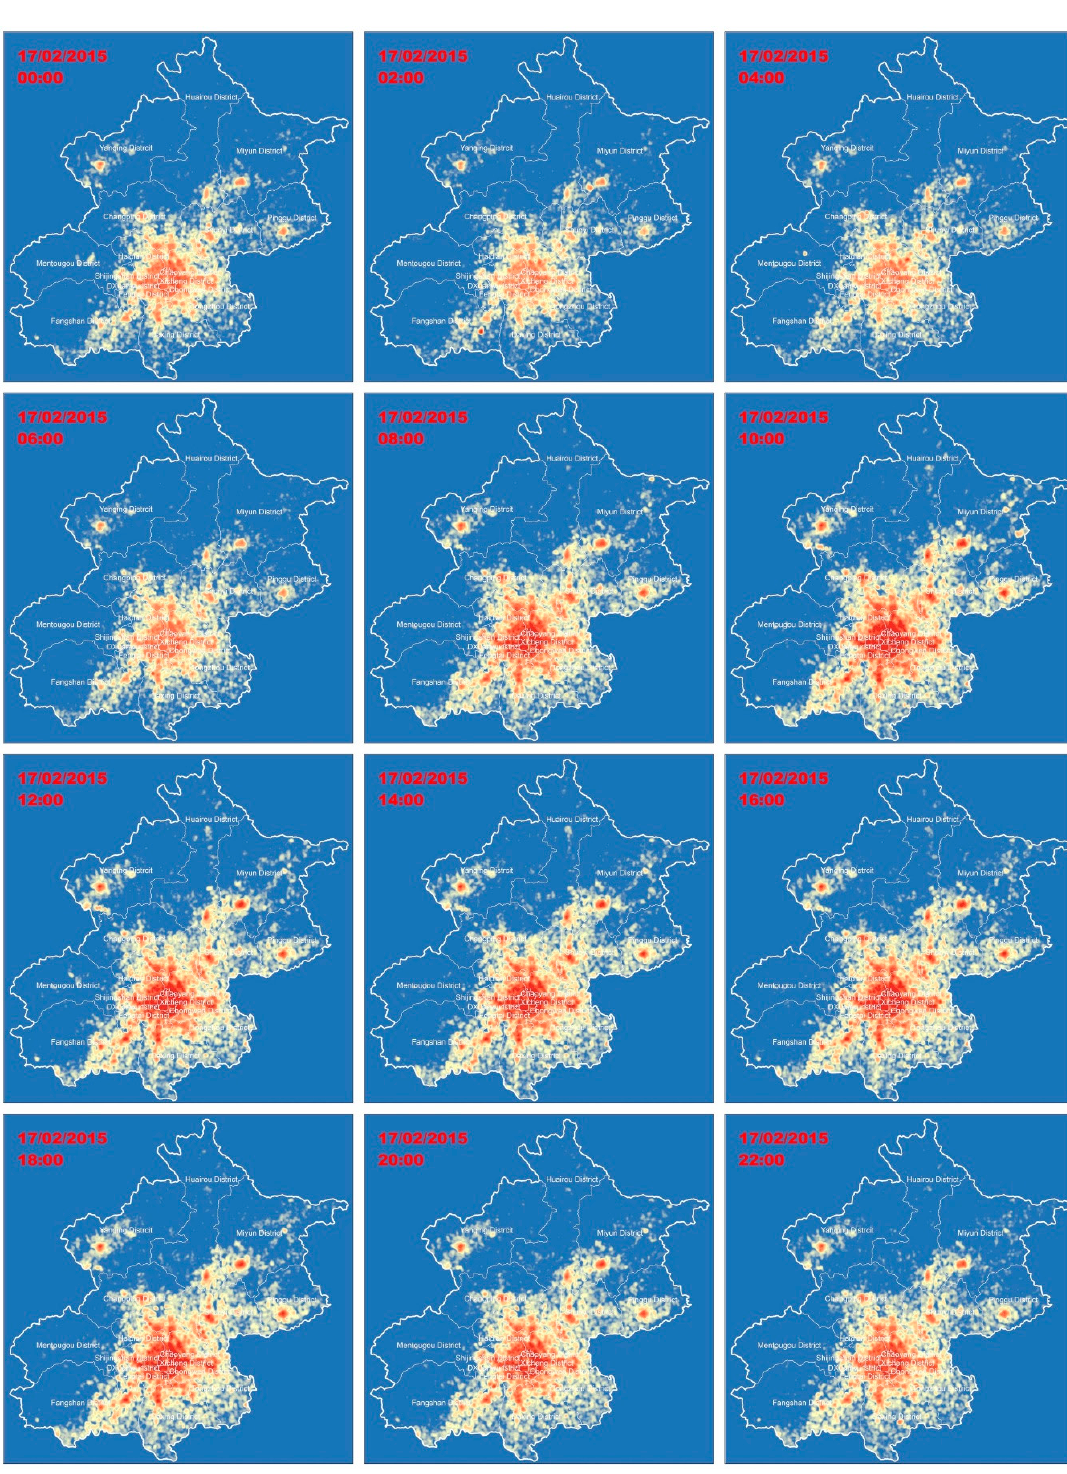
Figure 9. Mobile users’ distribution generated using the kernel density estimation (KDE) method on 17 February 2015 at a higher spatial resolution.